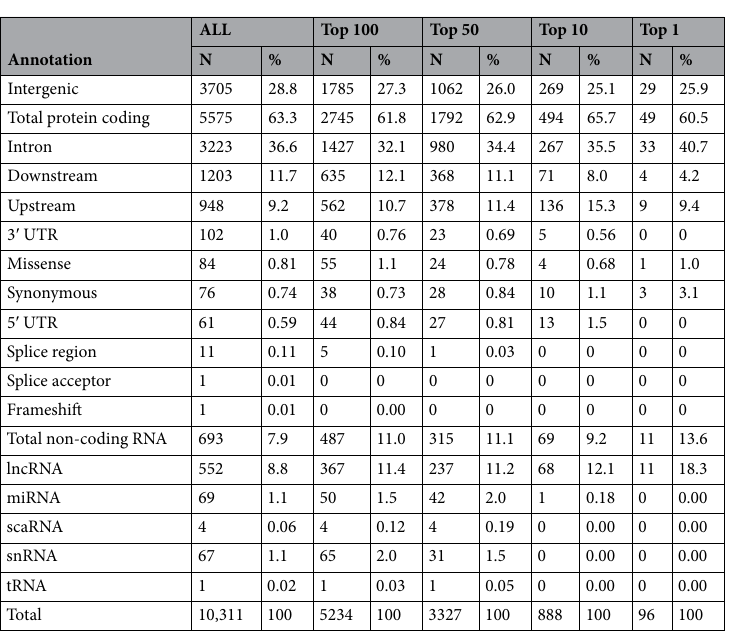
Table 6. Annotation of variants located within confidence intervals of the QTL (a single variant could have different annotations).